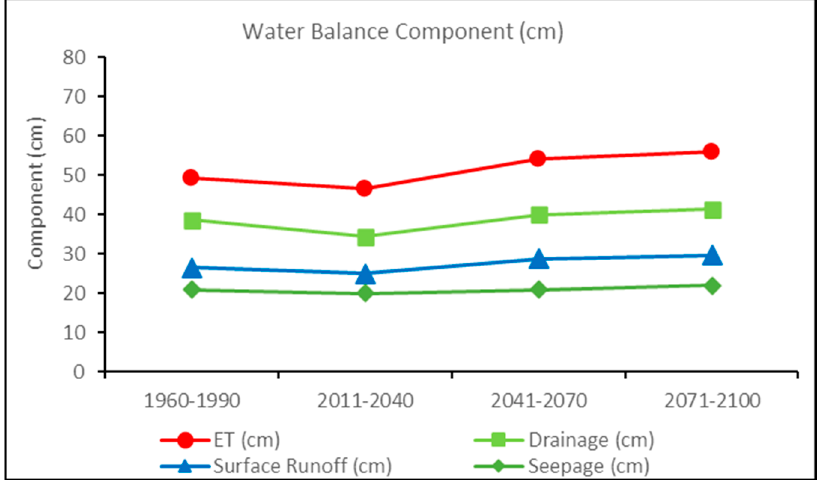
Figure 6. Simulated water balance components for 1960–1990, and 2011–2100 periods.